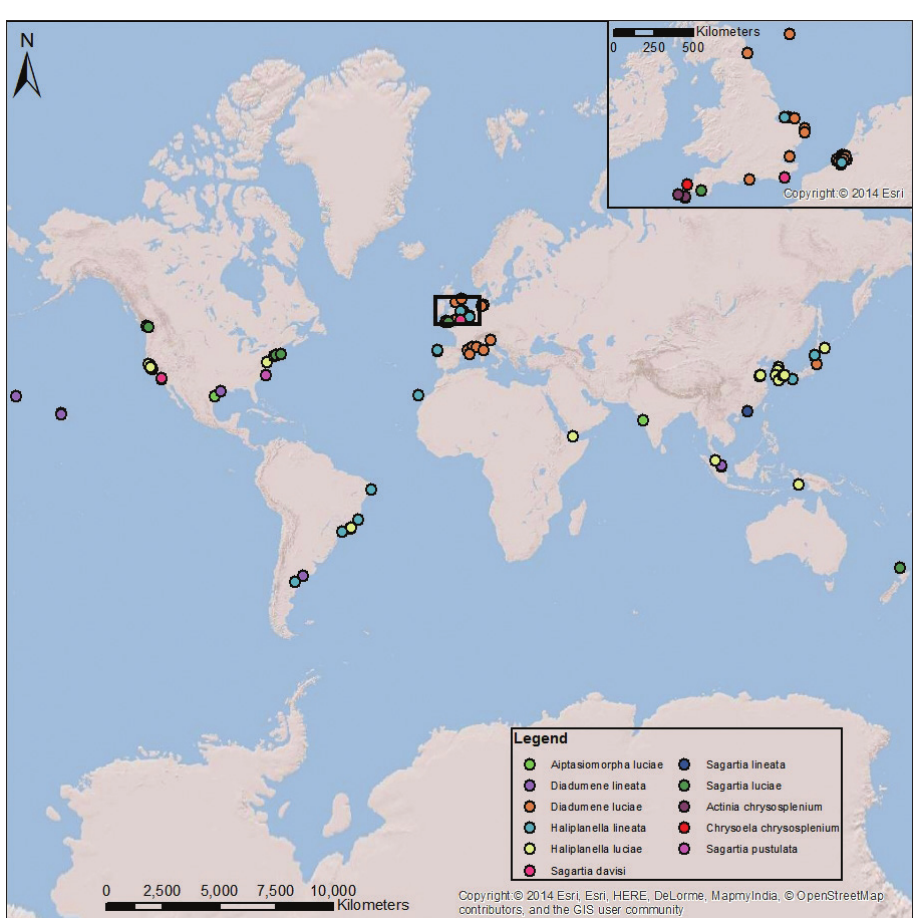
Figure 5. A map showing name usage by location for the synonyms of D. lineata , not including mis- spelled names. Inset shows Britain and the northern coast of Europe where there is a very high density of references (adapted from Fautin